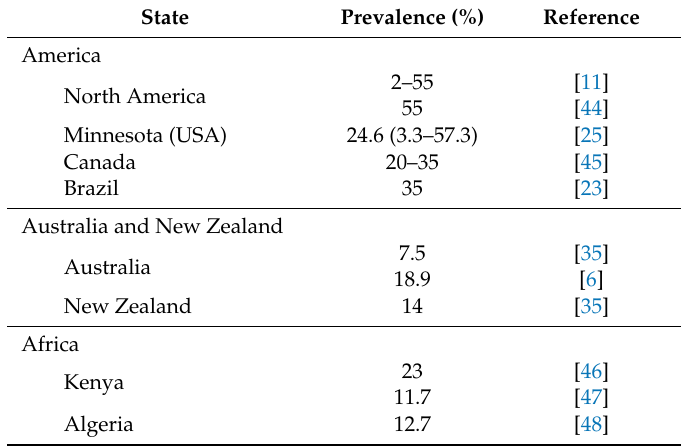
Table 1. Prevalence of lameness in dairy cows in di ff erent